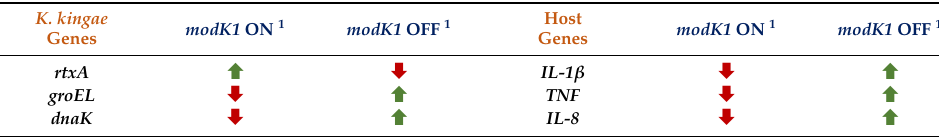
Table 2. K. kingae phasevarion.